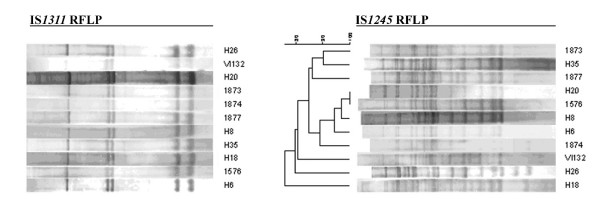
The figure illustrates a set of eleven isolates identical in their banding pattern by IS1311 RFLP, which could be further separated by IS1245 RFLP. A dendrogram is presented showing the cluster analysis of IS1245 RFLP.